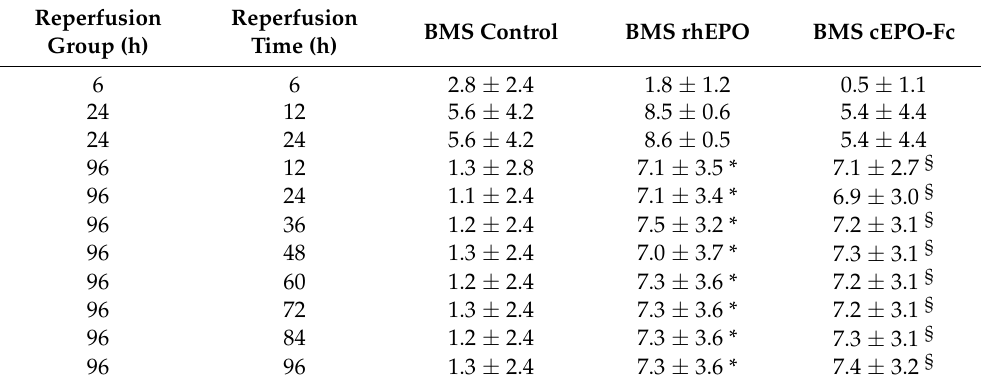
Table 1. Evaluation of the neurological status using the